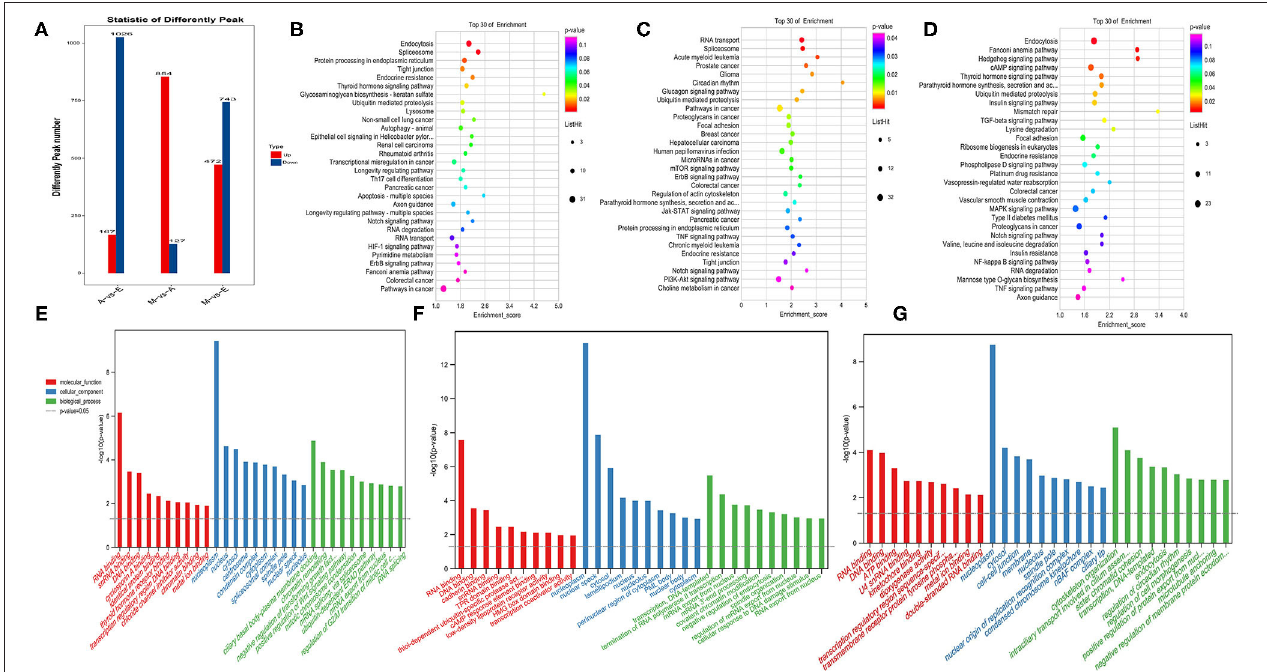
FIGURE 3 | Enrichment analysis of m6A-modified genes in each group. (A) The number of genes showed differential m6A methylation. (B–D) Kyoto encyclopedia of genes and genomes (KEGG) analysis in AvE, MvA, and MvE. (E–G) Gene ontology (GO) analysis in AvE, MvA, and MvE.